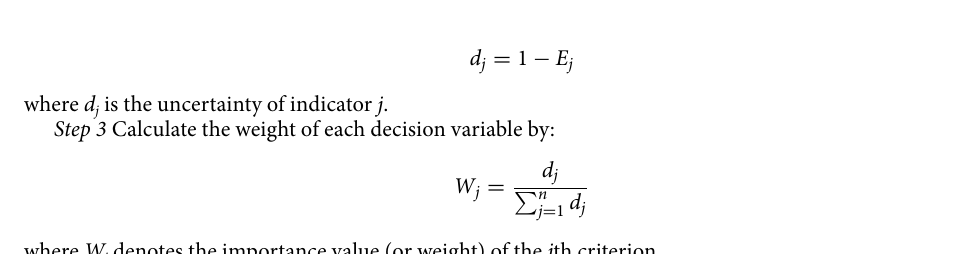
Table 3. Thirteen modeling scenarios and their water allocations to six industries. Industries 1–6 denote chemical, food and beverage, non-metal, equipment and machinery, metal, and textile,